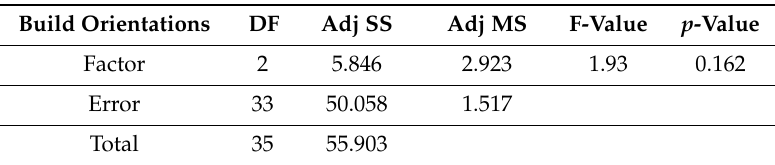
Table 18. ANOVA results for UTS as a function of build orientations.